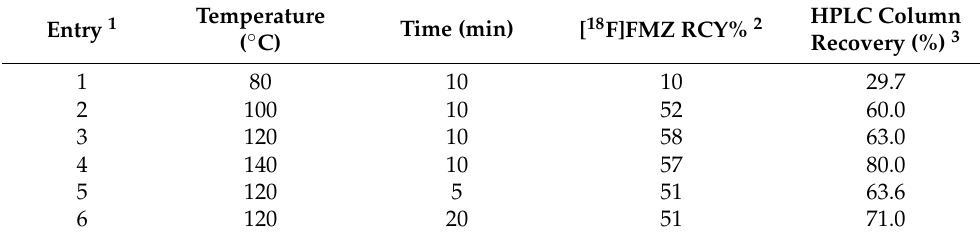
Table 1. Optimization conditions for the production of [ 18 F]FMZ 1 .